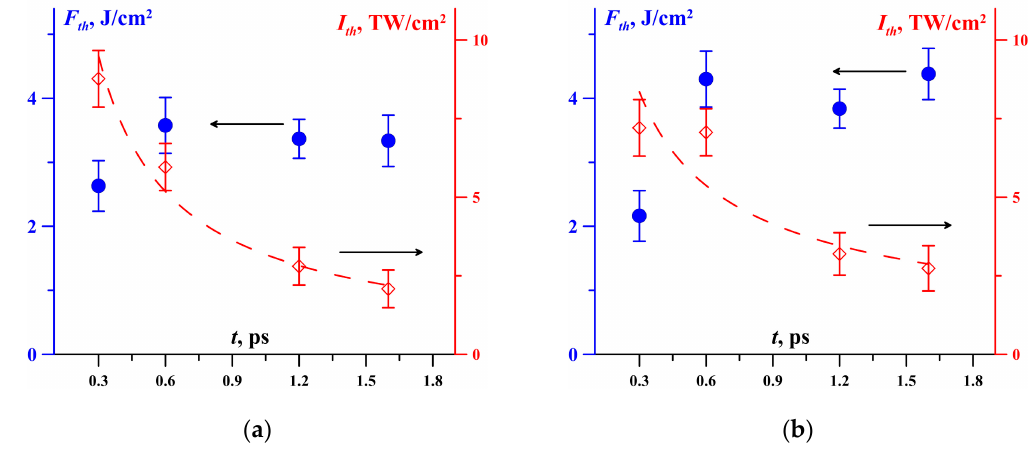
Figure 3. Dependence of optical damage threshold (fluence and intensity) of BWO crystal surface on the laser pulse duration at 515 nm wavelength for ( a ) “colored” and ( b ) “clear” BWO crystal.